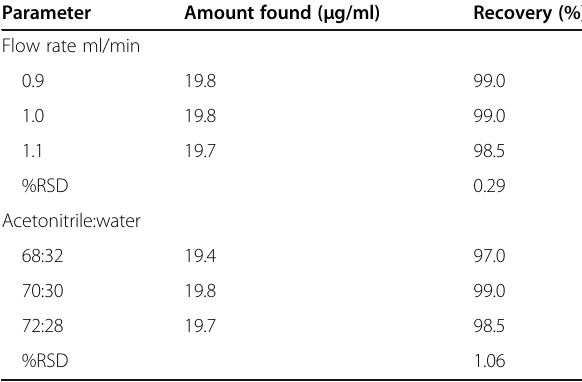
Table 5 Result of robustness